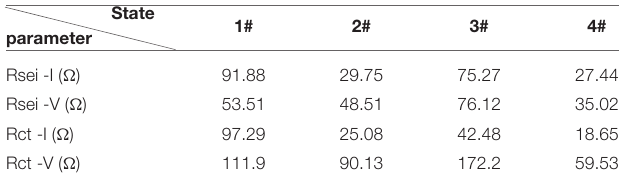
TABLE 2 | The fitting results within an equivalent circuit for the impedance spectra in Figure 7 . State parameter